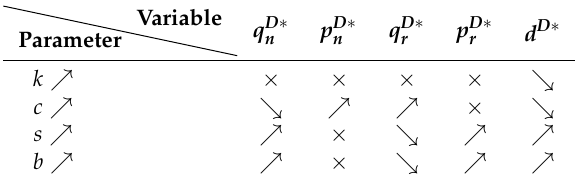
Variable D ∗ q D ∗ p D ∗ q D ∗ p D ∗ Parameter n n r r d